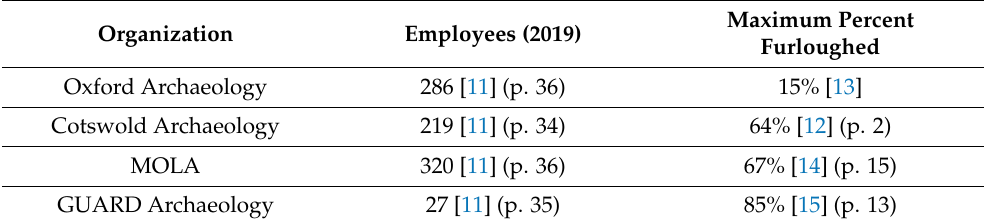
Table 2. Percentages of Staff Furloughed at Selected Archaeological